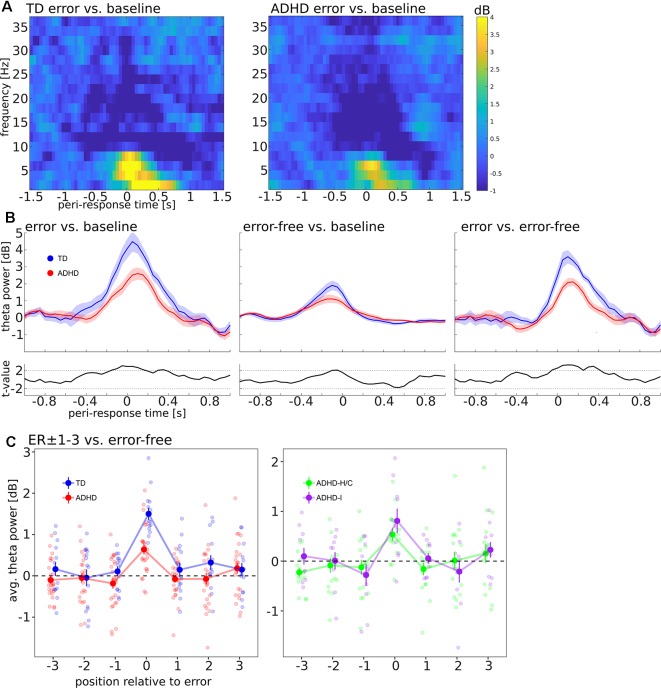
(A) Baseline-corrected time-frequency representation, locked to error responses. Panels show log-power for frequencies from 2 to 36 Hz in steps of 2 Hz, averaged over electrodes Fz and Cz, compared to a pre-cue baseline (−750 to −250 ms). Left panel: TD, Right panel: ADHD. (B) Mean ± SEM of change in the theta band, averaged over frequencies (4–8 Hz) and electrodes (Fz, Cz). Left and middle panel show error and error-free trials, respectively, compared to pre-cue baseline, the right panel shows error compared to error-free trials. Blue Curves: TD, Red curves: ADHD, black curves below: t-values comparing TD and ADHD; dashed black lines indicate t = 2.02, the (uncorrected) threshold for two-tailed statistical significance at df = 38. (C) Time-averaged theta power (−400 to +400 ms relative to responses) in peri-error trials in TD vs. ADHD (left) and compared between ADHD subtypes (right).